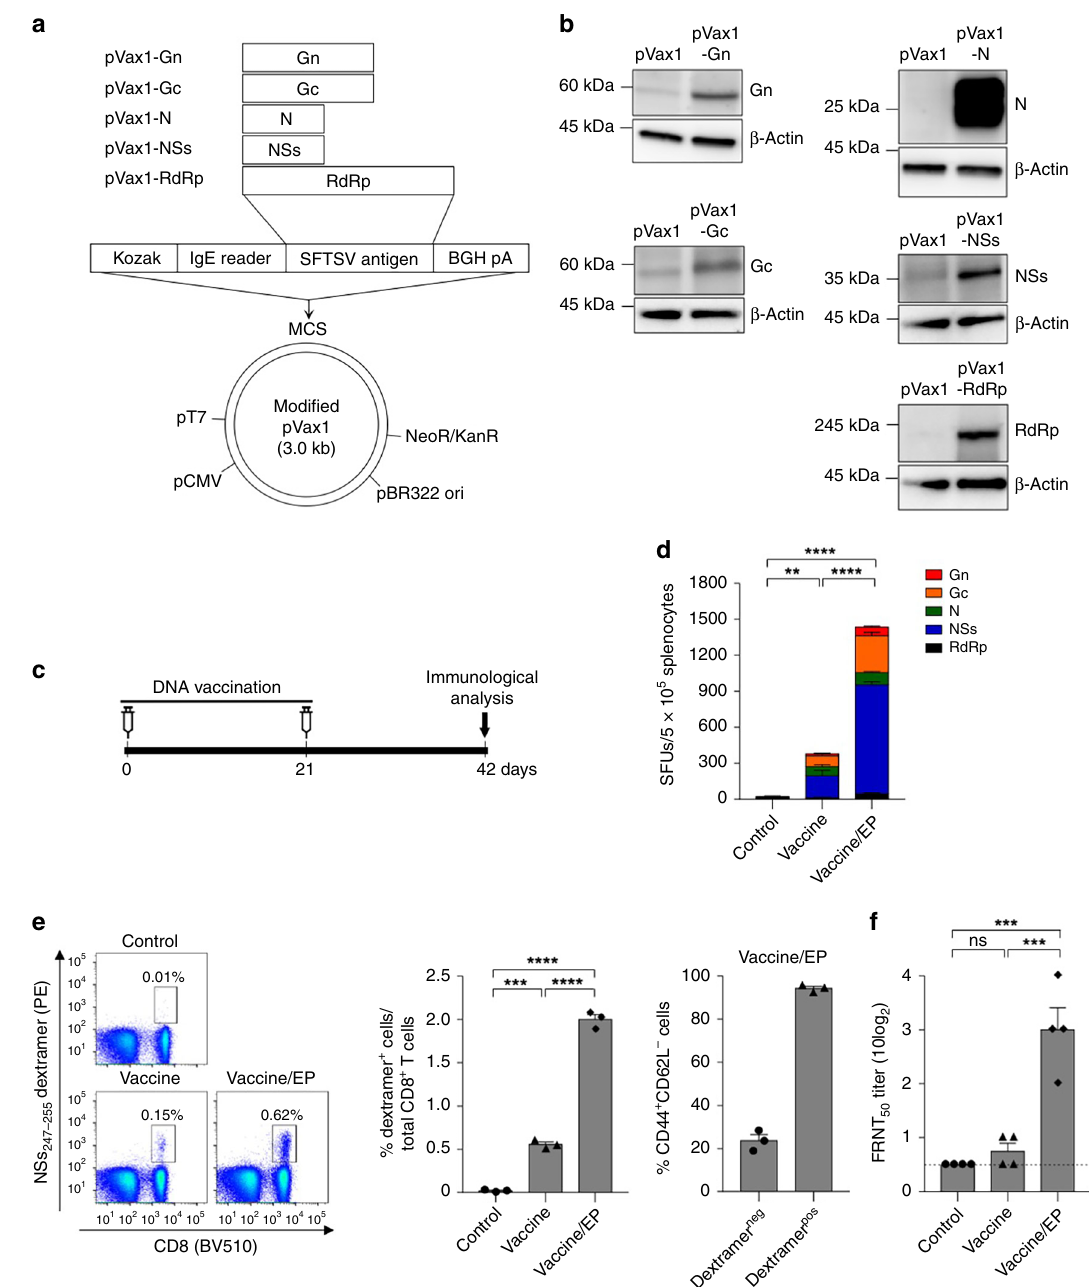
Fig. 1 Immunogenicity of SFTSV DNA vaccines in BALB/c mice. a Diagram of SFTSV DNA vaccines comprising fi ve plasmids encoding SFTSV antigens derived from the common sequence of 31 SFTSV strains. b Western blot analysis of SFTSV DNA vaccine expression in 293T cells. c Immunization schedule (Supplementary Fig. 1a shows a detailed timeline of vaccination and immune analysis). d T-cell immunogenicity of SFTSV DNA vaccines in BALB/c mice. IFN- γ ELISpot assays were performed to detect antigen-speci fi c IFN- γ -producing T cells by stimulating splenocytes from immunized mice with overlapping peptide (OLP) pools. Data (mean ± s.e.m.) represent the average number of spot-forming units (SFUs) per 5 × 10 5 splenocytes. e Frequency of effector memory (CD44 + CD62L − ) CD8 + T cells among SFTSV NSs 247 – 255 -speci fi c CD8 + T cells. Splenocytes from vaccinated mice were stained with H-2L d NSs 247 – 255 dextramer to identify SFTSV NSs 247 – 255 -speci fi c CD8 + T cells. Then the frequency of CD44 + CD62L − CD8 + T cells in this population was examined by multi-color FACS analysis. f Neutralizing antibody response to SFTSV CB1/2014 strain (genotype B) generated by SFTSV DNA vaccines in BALB/c mice. In anti-sera collected from vaccinated mice, the amount of neutralizing antibody against SFTSV was determined based on FRNT 50 . Error bars indicate the mean ± s.e.m. Statistical signi fi cance was determined by one-way ANOVA test with Tukey correction. **p < 0.01 ; ***p < 0.001 ; ****p < 0.0001. Source data are provided as a Source Data fi le